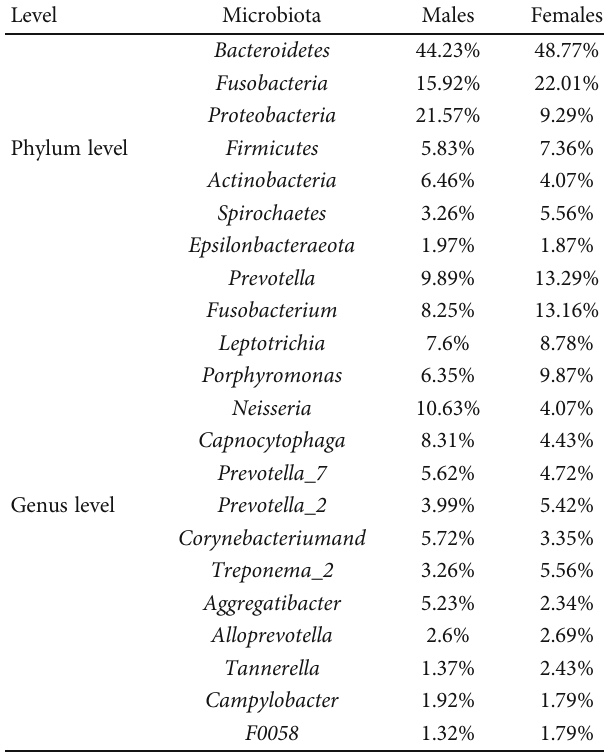
Table 3: The main microbiota ( > 1%) at the phylum and genus level and their